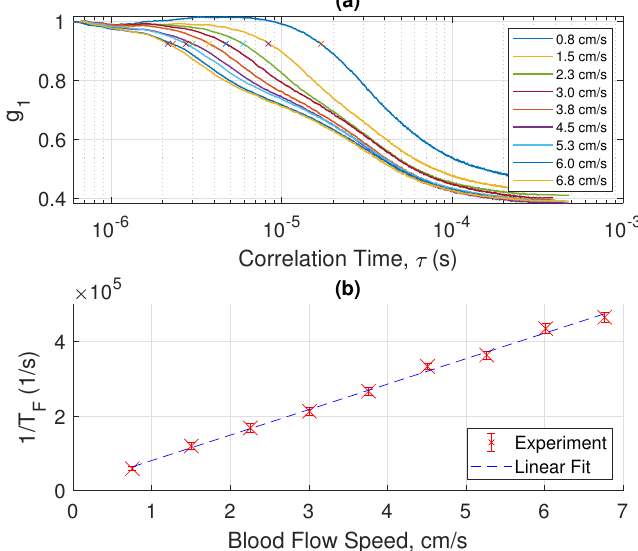
Figure 2. ( a ) Measured E-field correlation function ( g 1 ) versus flow speed of whole blood for a tube diameter of 1.68 mm. ( b ) By taking the inverse of the correlation time at the first inflection point in ( a ), marked using ‘X’, the decorrelation rate (1/ T F ) is plotted versus the flow speed. The scattered data set with error bars represents the 95% confidence interval over 25 measurements, each for a duration of 1 s. The dashed line is a linear fit of the measured